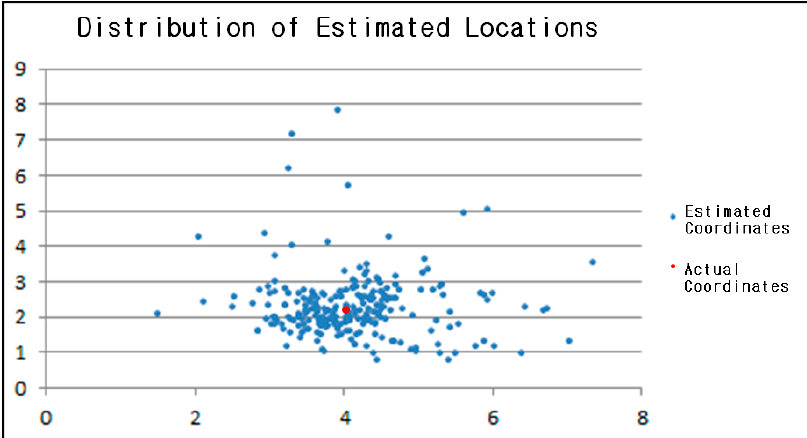
Figure 14. Distribution graph for the estimated locations.